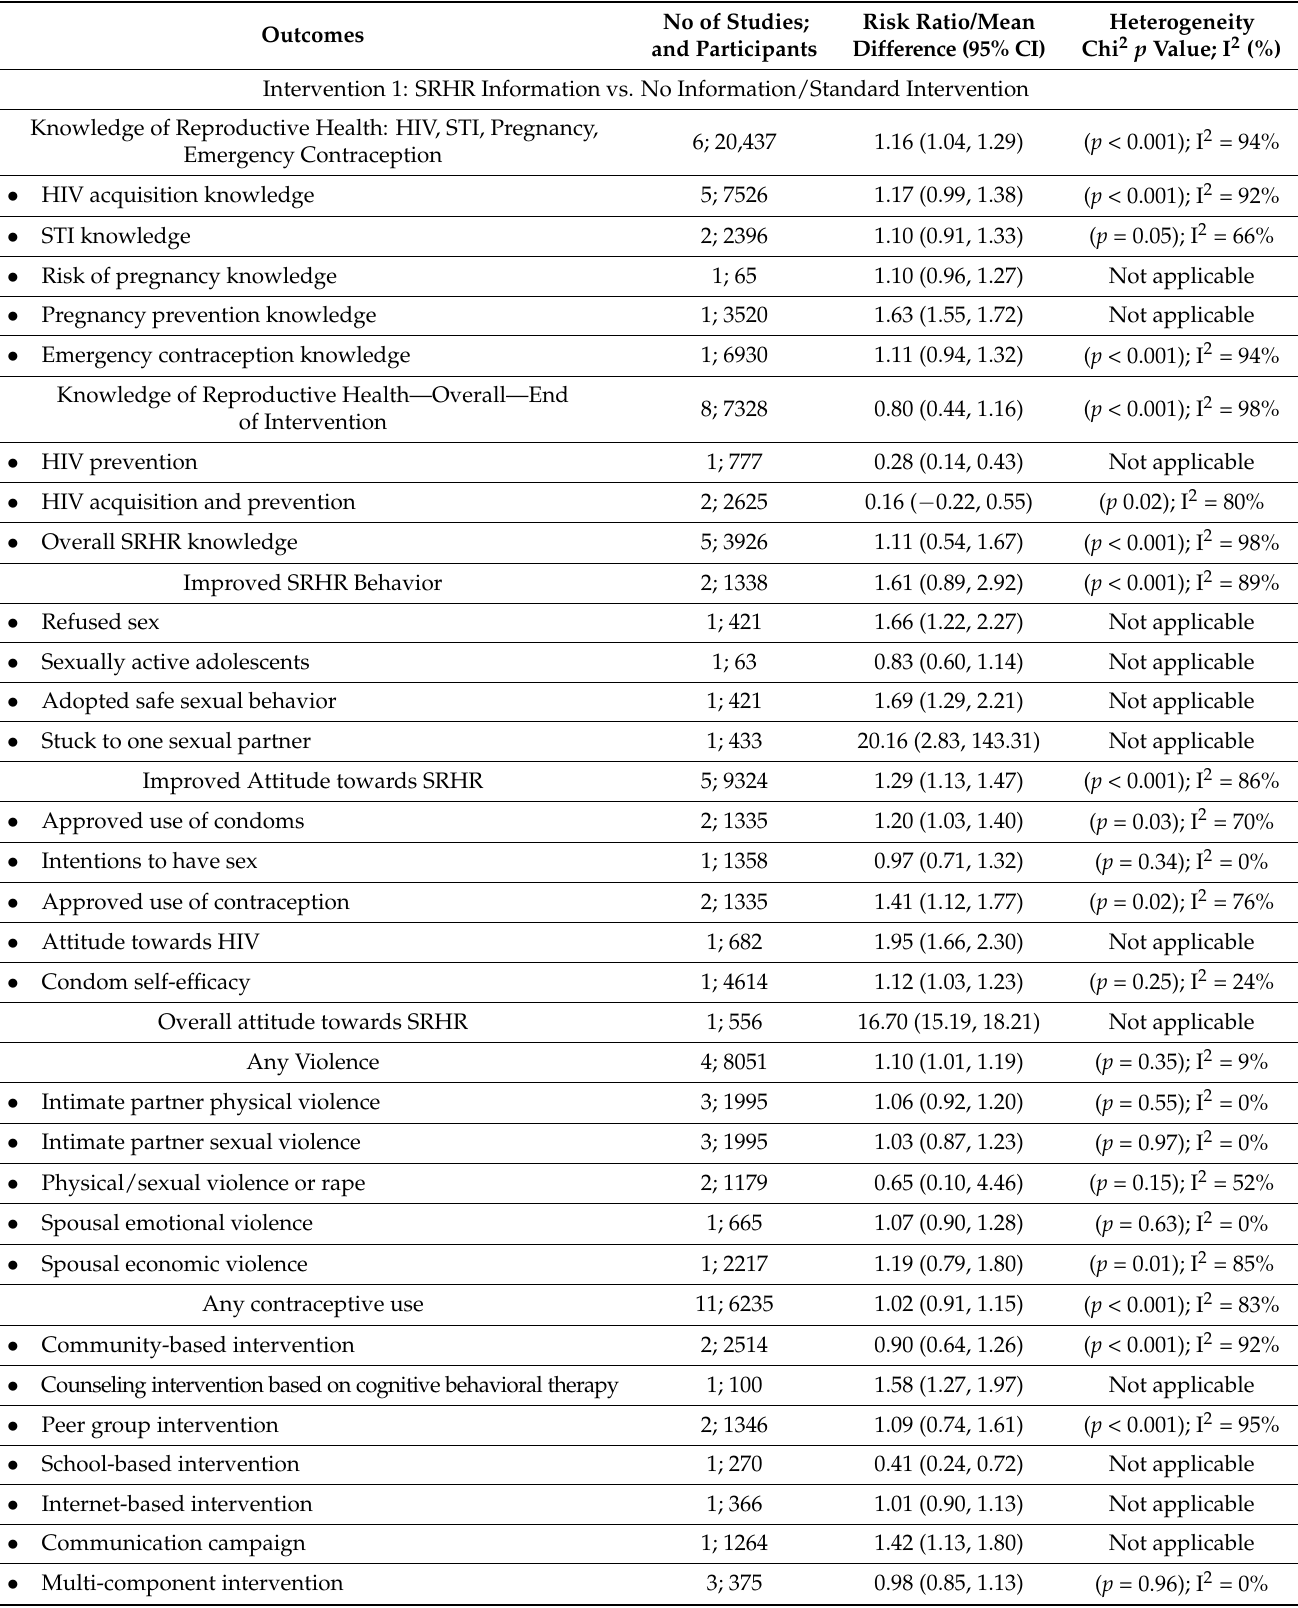
Table 2. SRHR Interventions and